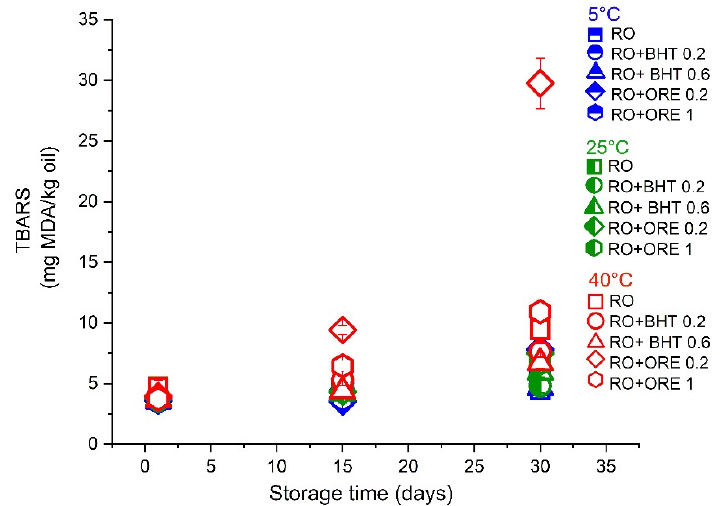
Figure 4. TBARS values of oil samples (pure raspberry oil–RO) and RO with added antioxidants (butylated hydroxytoluene—BHT, 0.2 or 0.6 wt%, and oregano essential oil—ORE, 0.2 or 1 wt%) at 5, 25, and 40 °C during one month of storage. The results are expressed as mg of malonaldehyde/kg oil (mg MDA/kg oil).